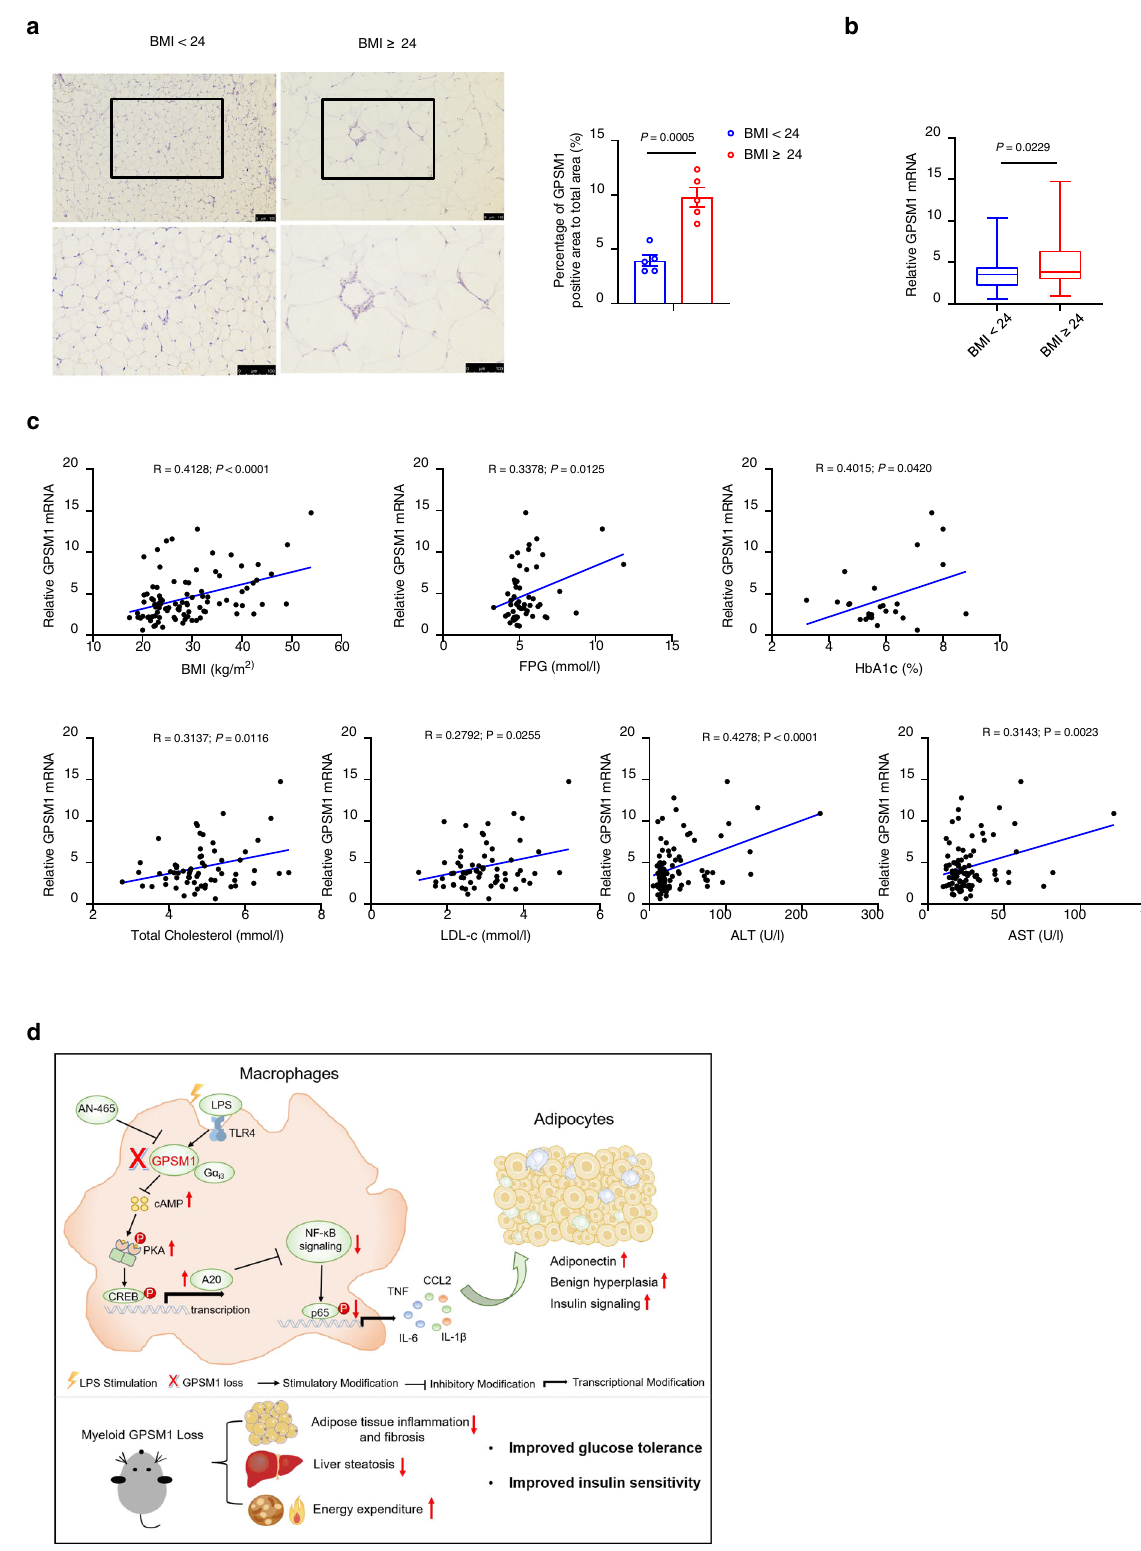
546 donkey anti-rabbit IgG (A10040, 1:1000) purchased from Thermo Fisher Scienti fi c. Images were then captured using a fl uor- escence microscope (Leica) and analyzed by ImageJ (National Institutes of Health) version